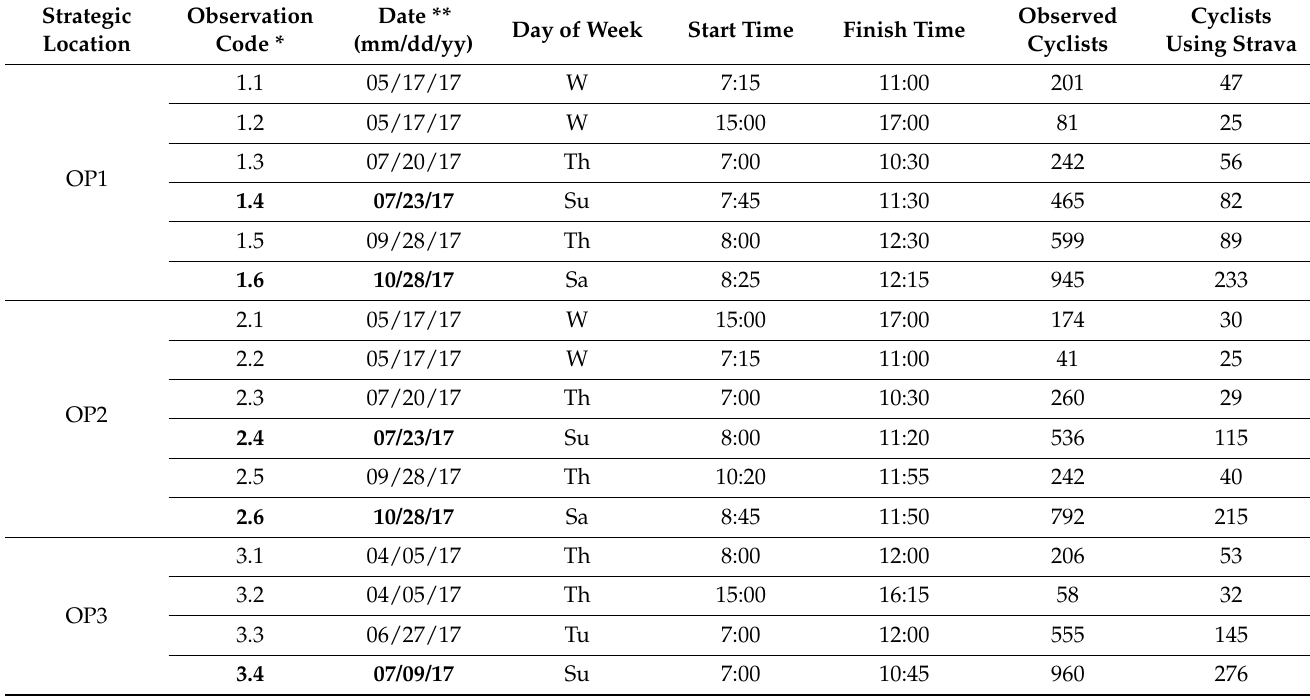
Table 1. Field data